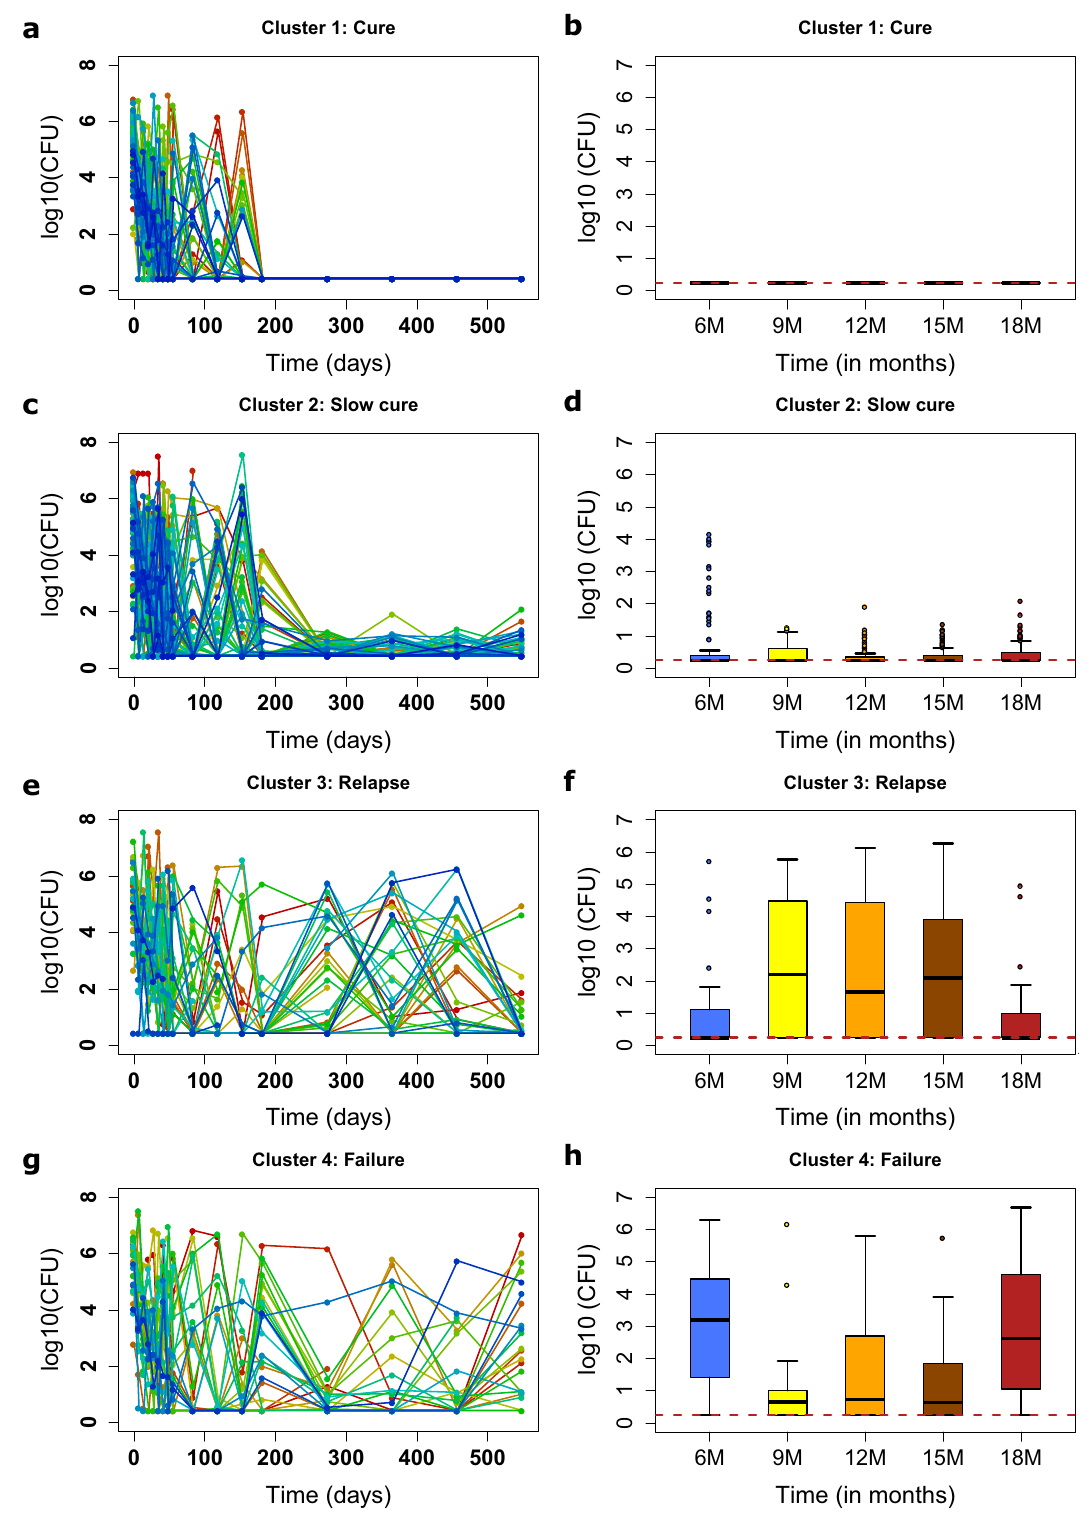
Fig. 3 Clusters of treatment outcomes. Clusters of CFU/TTP trajectories of each individual patient are shown side by side with median log 10 CFU/mL plus interquartile range, for the follow up periods of 6 to 18, months. a Cured patients ’ trajectories and b summary of trajectories during follow-up. c Slow cure trajectories and d box-plots of CFUs after therapy completion. Relapse patterns e and the corresponding patterns during follow up f . Failed treatment cluster g and follow-up period summarizing boxplots h